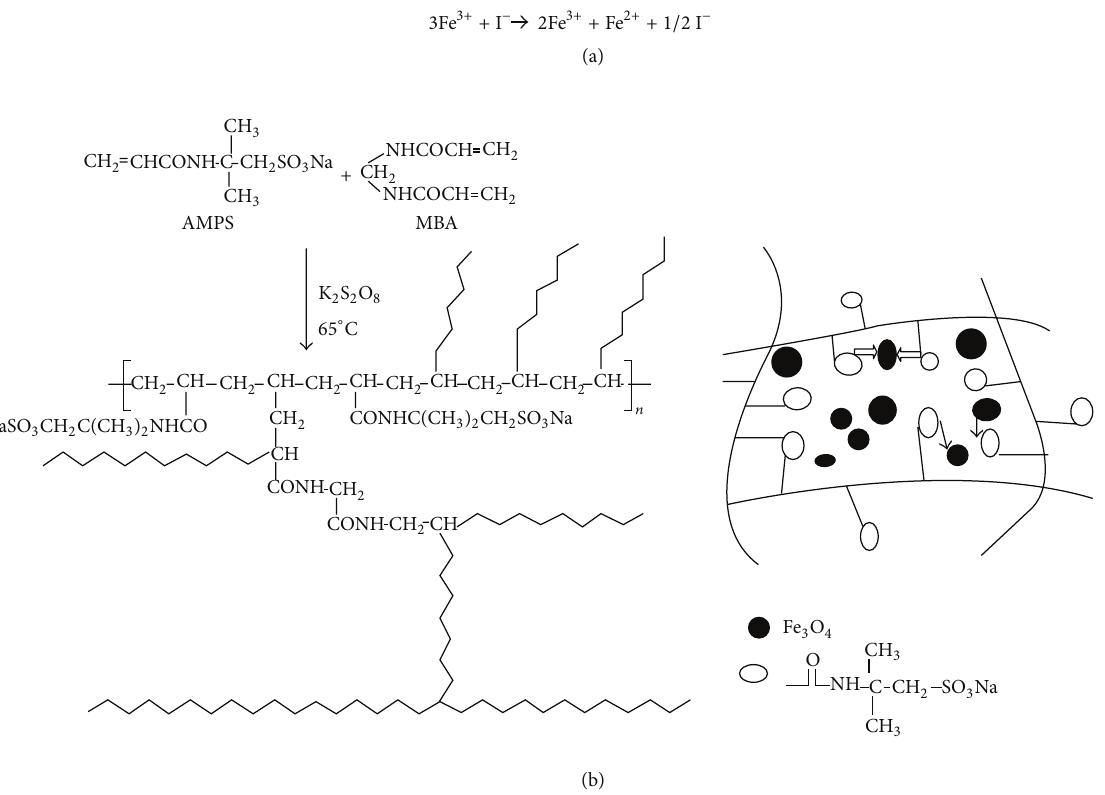
Scheme 1: Preparation of (a) magnetite and (b) Fe 3 O 4 /P(AMPS)